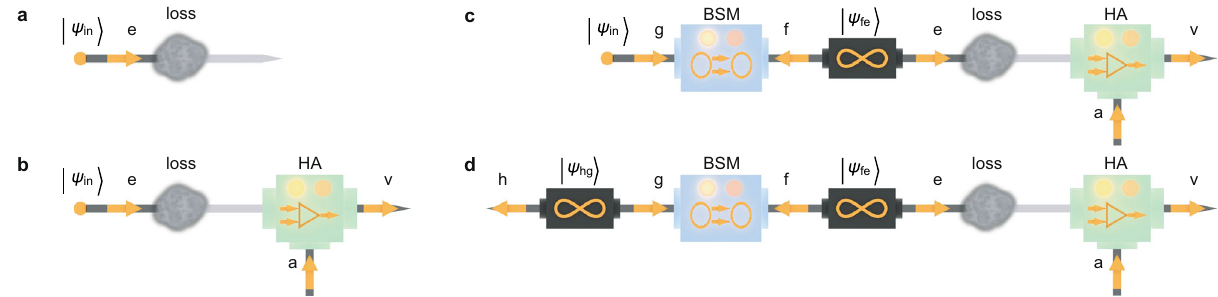
Fig. 1 Conceptual representations of quantum state transmission through a lossy channel, with and without correction. a A quantum state, here a qubit encoded in a single mode “ e'', is transmitted through a lossy channel, which degrades the state quality. b After the loss, the noisy state can be corrected using a heralded ampli fi er (HA). Mode “ a ” carries the ancilla photon that powers the HA. The operation of HA has an independent success signal, so (cid:1) (cid:3) (cid:1) postselection is not required. However, HA failure destroys the state. c By adding a mode-entangled state ψ , success of the HA heralds a noise- fe corrected quantum channel. This can be used upon success by teleporting a qubit in mode “ g ” onto mode “ v ” via a Bell state measurement (BSM) between (cid:1) (cid:3) (cid:1) “ g ” and “ f''. d Instead of transmitting a qubit ψ through the lossy or corrected channel, it is possible to transmit half of an entangled state, leading to in distributed entanglement through a heralded corrected channel in the